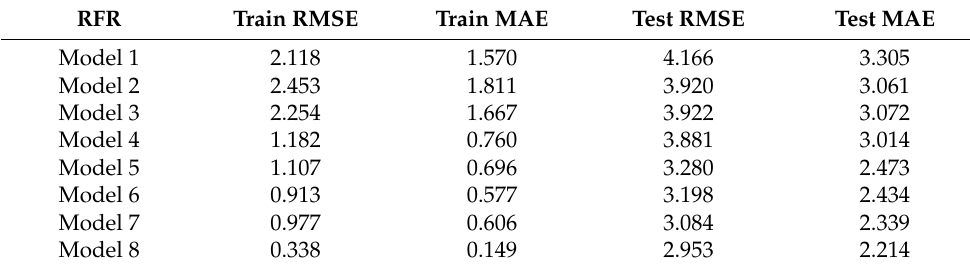
Table 6. Train and test RMSE and MAE for all RFR models.